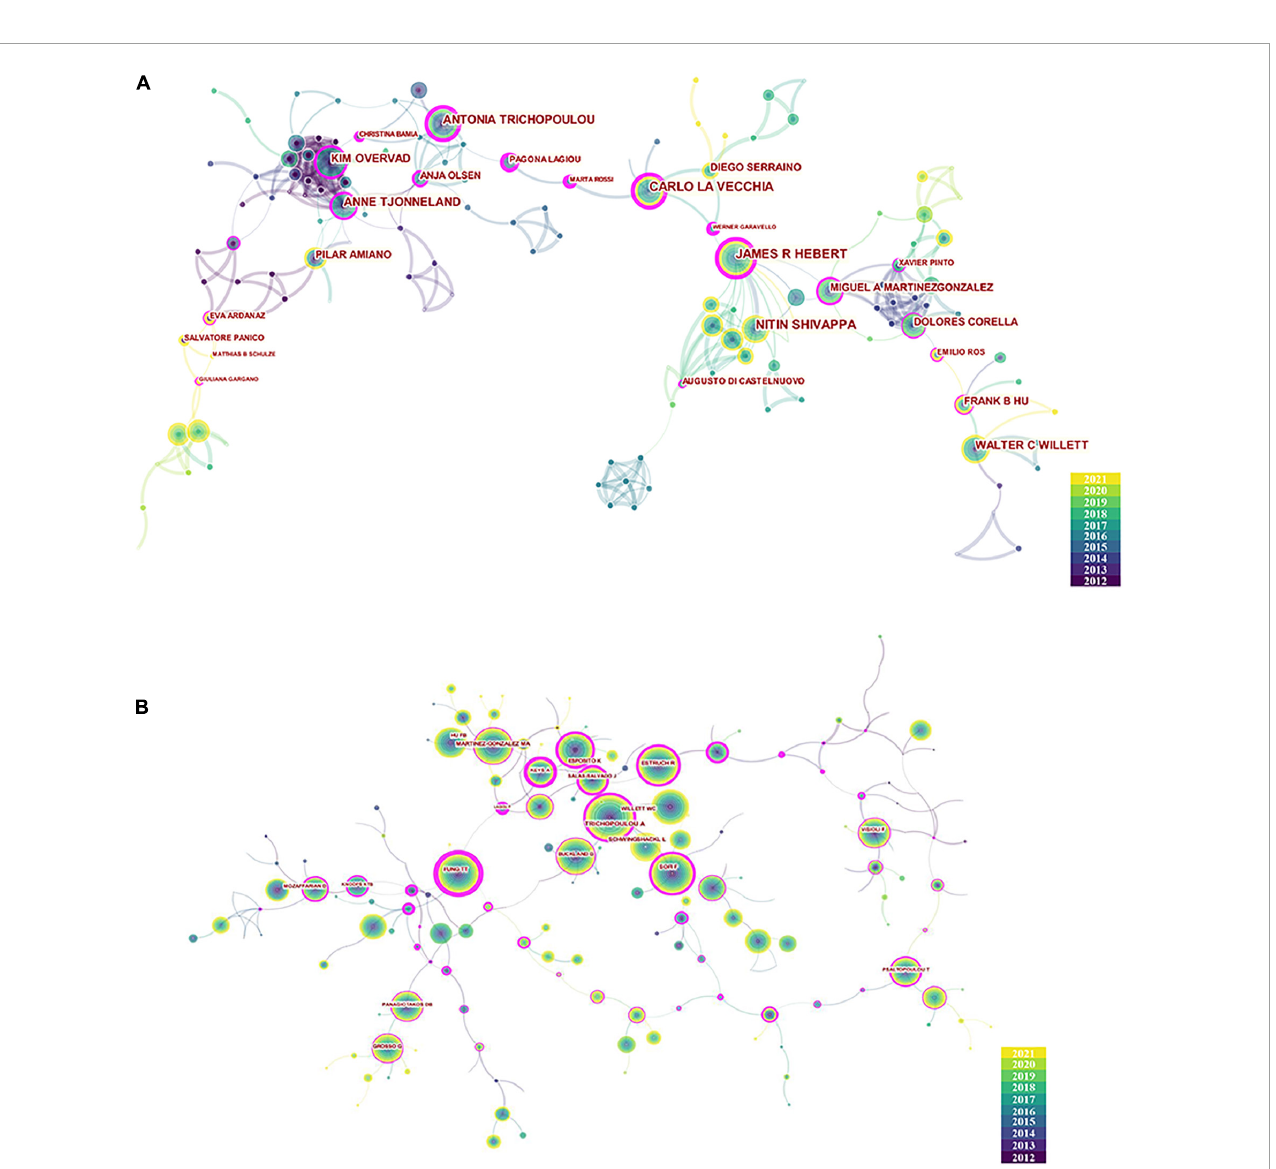
FIGURE6 The collaboration map of panel (A) authors and (B) co-cited authors.